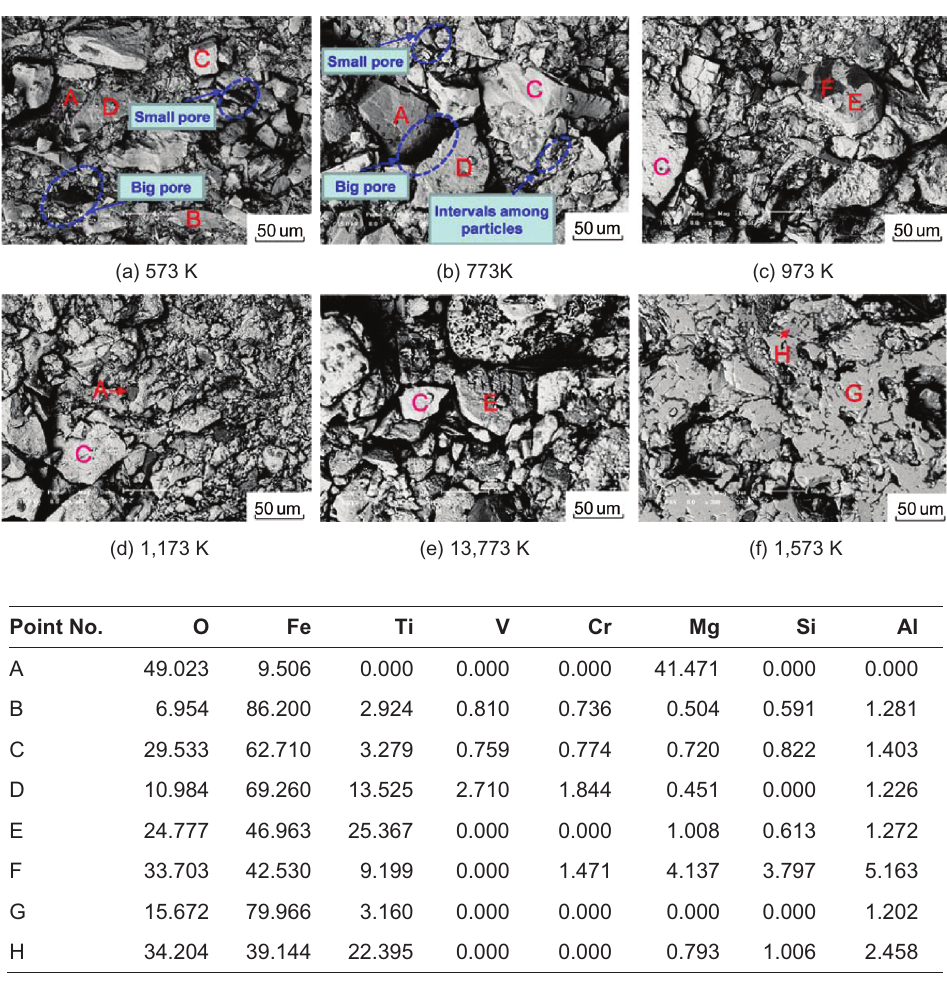
Figure 7: SEM images with EDS analyses (mass %) of HCVTM oxidized pellet at different